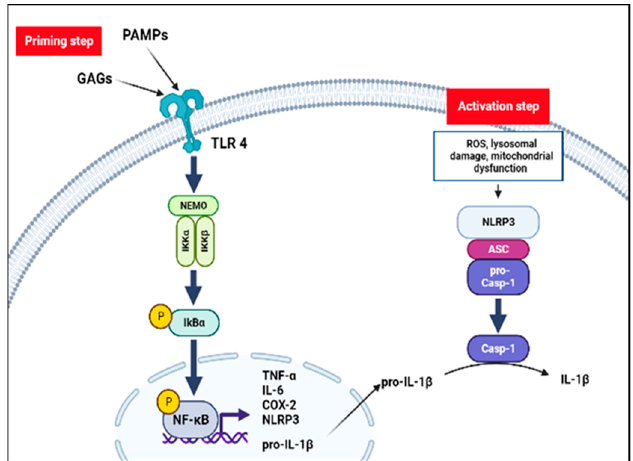
Figure 2. The inflammatory hypothesis in MPS. Inflammasome activation requires two-step. Pathogen-associated molecular-patterns (PAMPs) and unfractionated glycosaminoglycans (GAGs) stimulate inflammatory processes through a Toll-like receptor 4 (TLR4) pathway: the inhibitory subunit of NF-kB alpha (I κ B α ) is phosphorylated by the NF-kappa-B essential modulator (NEMO) complex liberating NF- κ B dimer. Translocation of NF-kB dimer to the nucleus promotes NOD-like receptors family pyrin domain containing 3 (NLRP3) and proinflammatory cytokines transcription (priming step). Lysosomal damage, mitochondrial dysfunction and oxidative stress may mediate the NLRP3 inflammasome assembly and activation (activation step). NLRP3 together with the adaptor apoptosis-associated speck-like protein containing a CARD (ASC) protein promotes the activation of caspase-1 and forms NLRP3 inflammasome complex. Finally, caspase-1 mediates conversion to the active form of IL-1 β